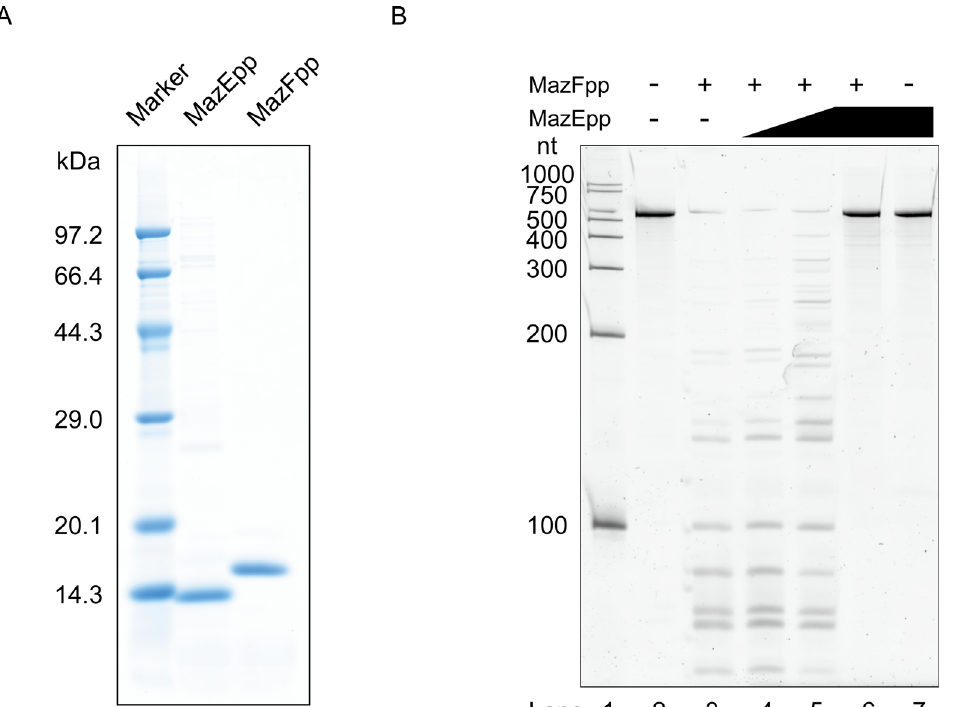
Fig 3. MazEF pairs in Pseudomonas putida . (A) Molecular weight and the purity of the hexa-histidine tagged MazEpp and MazFpp. (B) Enzymatic activity of MazEpp and MazFpp. A 533-base synthetic RNA (RNA 500 – 2) was incubated with these enzymes. Lane 2, a control reaction without any enzymes; Lanes 3 – 6, 3 pmol of MazFpp was added. For lanes 4 – 6, MazE-pp was also added to each lane: 0.3, 3, and 30 pmol respectively. Lane 7, 30 pmol of MazEpp was